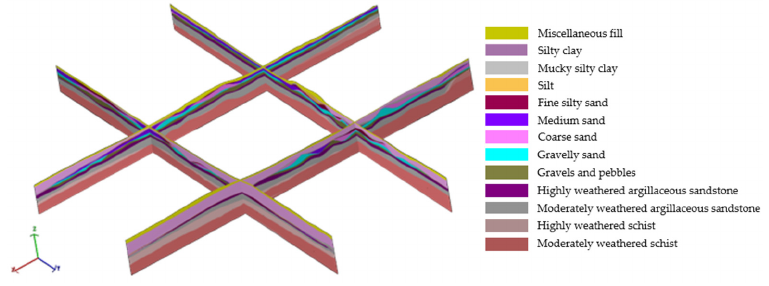
Figure 14. The profiles of random side. ISPRS Int. J. Geo-Inf. 2020 , 9 , x FOR PEER REVIEW